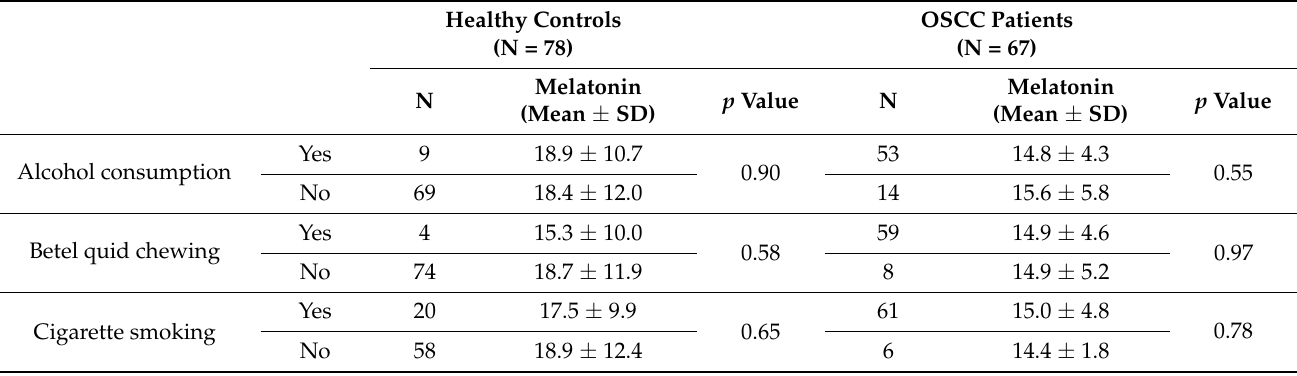
Table 2. Serum melatonin levels classified by alcohol consumption, betel quid chewing, and cigarette smoking among healthy controls and OSCC patients.